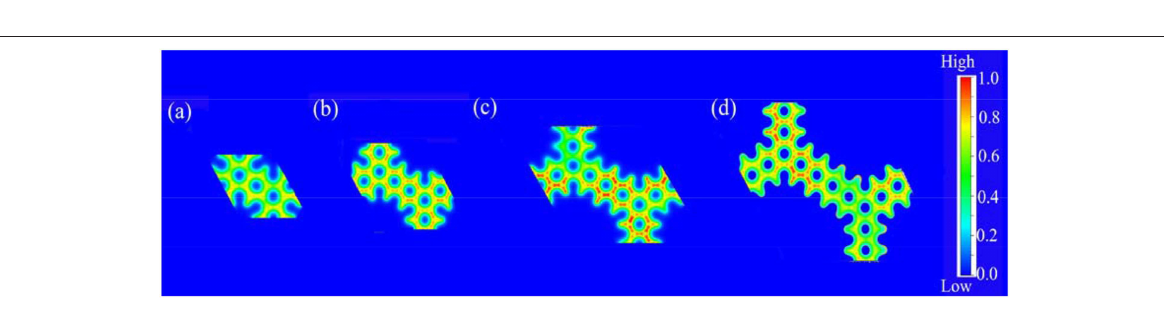
FIGURE 2 | Charge density distribution pictures of two-dimensional closed conjugated COPs ( a , COP-B3; b , COP-B4; c , COP-B5; d , COP-B6).